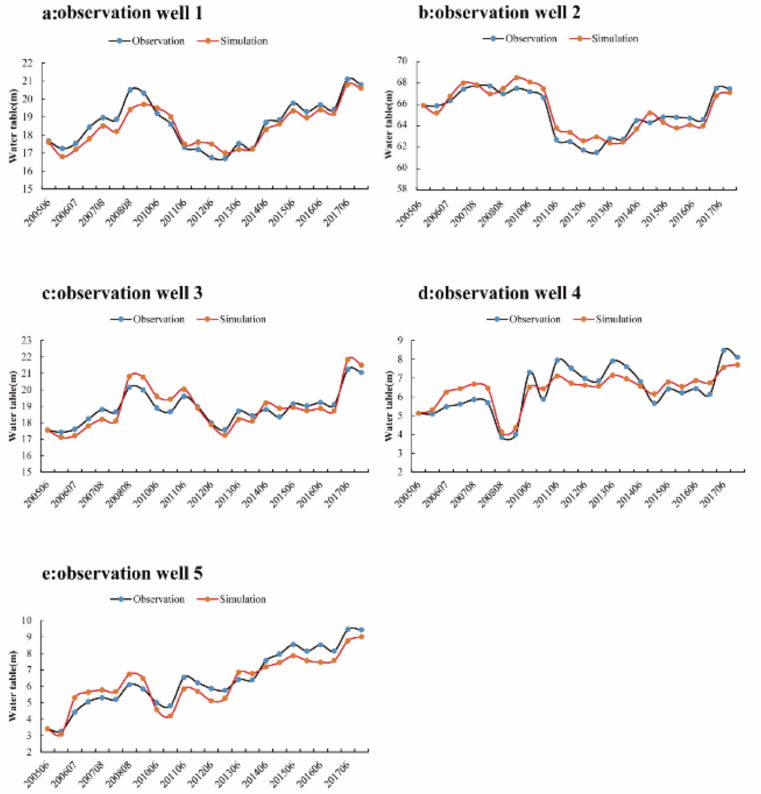
Figure 8. ( a – e ) Time comparison of groundwater level elevation observed and simulated by 5 observation wells during calibration